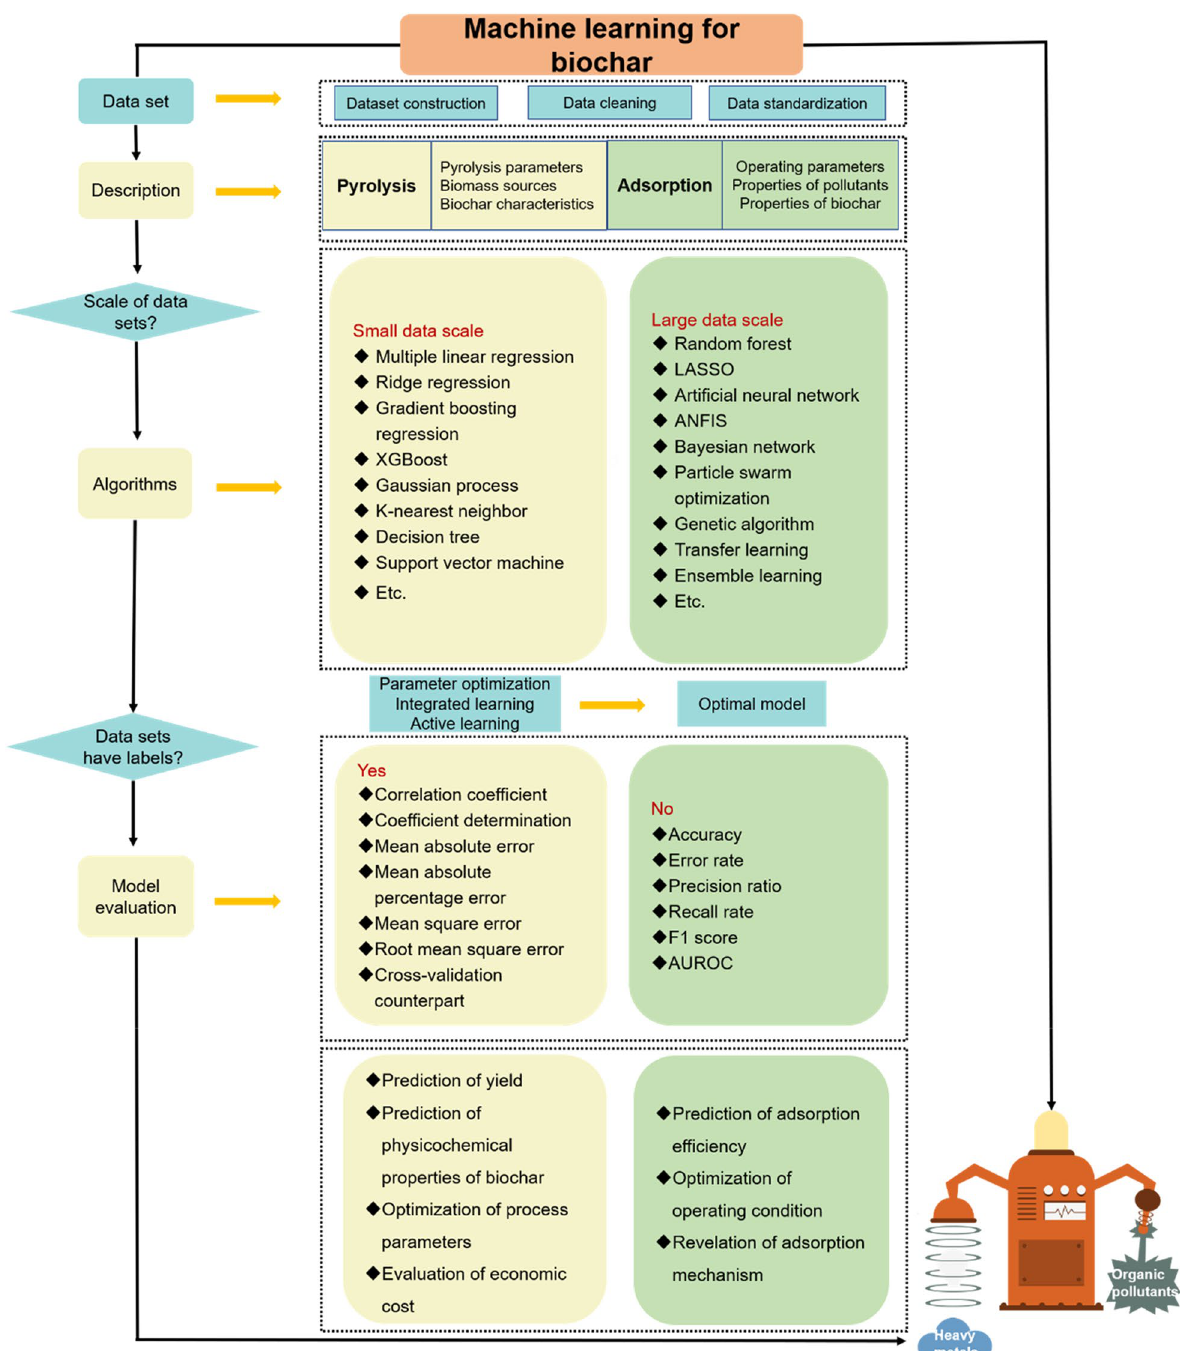
Fig. 6 General guidelines for the application of machine learning in the whole process regulation of biochar from synthesis to